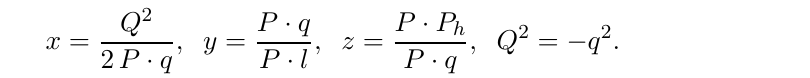
points in the direction of the x-axis from which azimuthal angles are counted. The